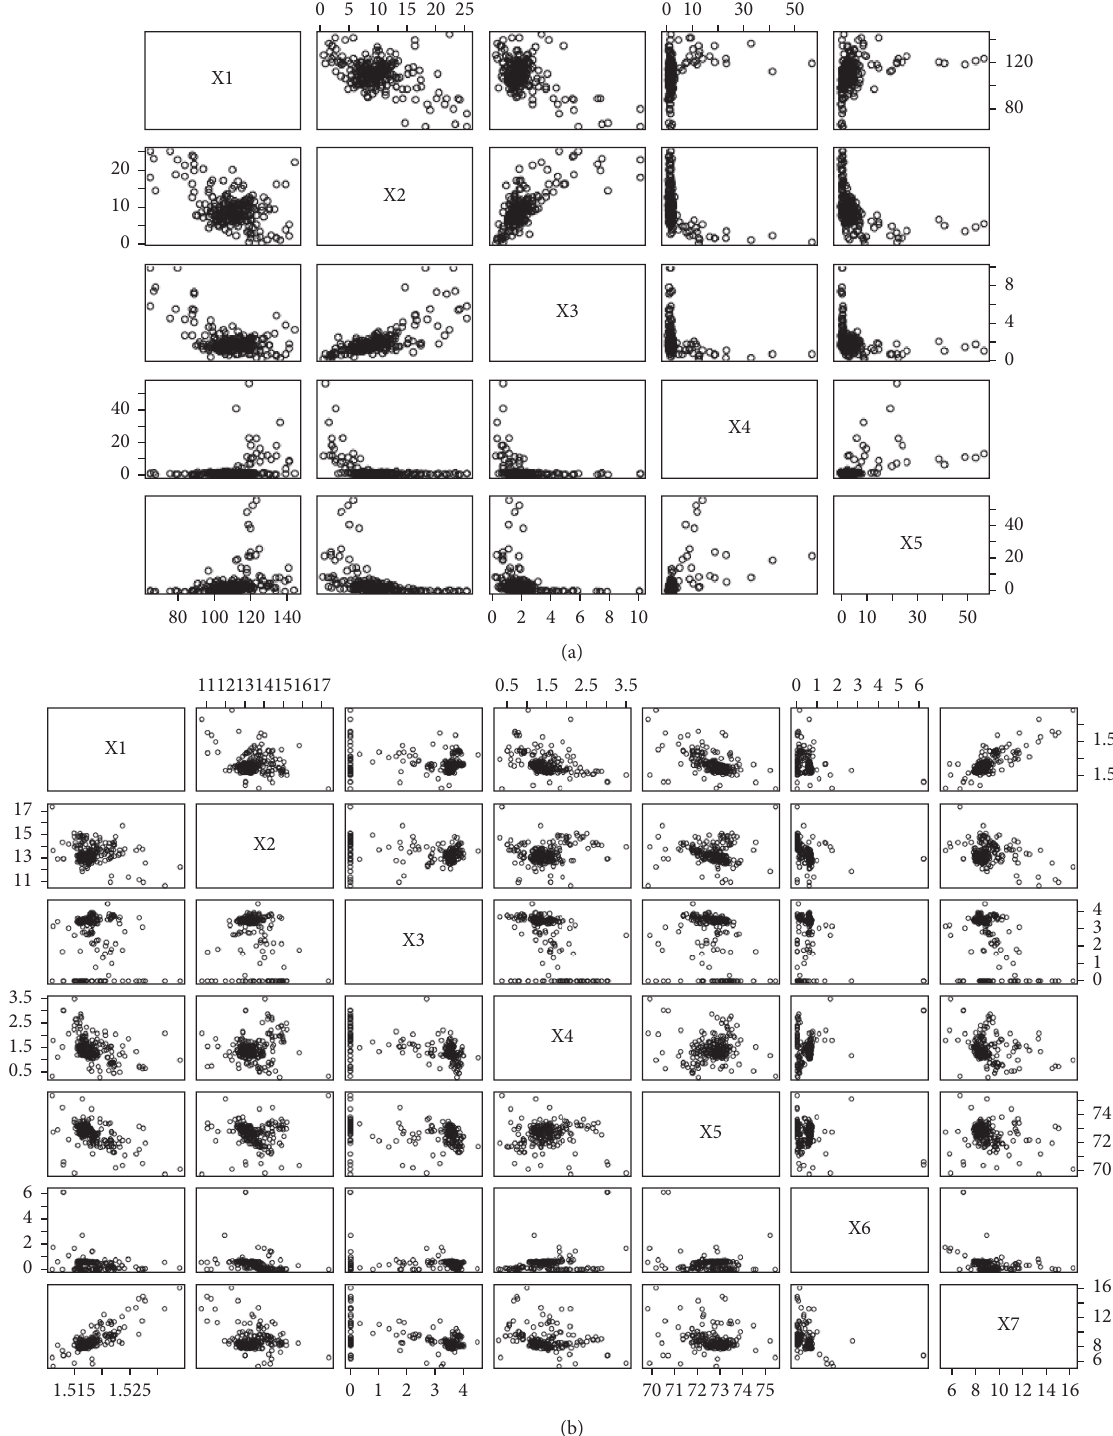
Figure 5: Scatter pair plots of the real datasets. (a) Newthyroid dataset. (b) Glass